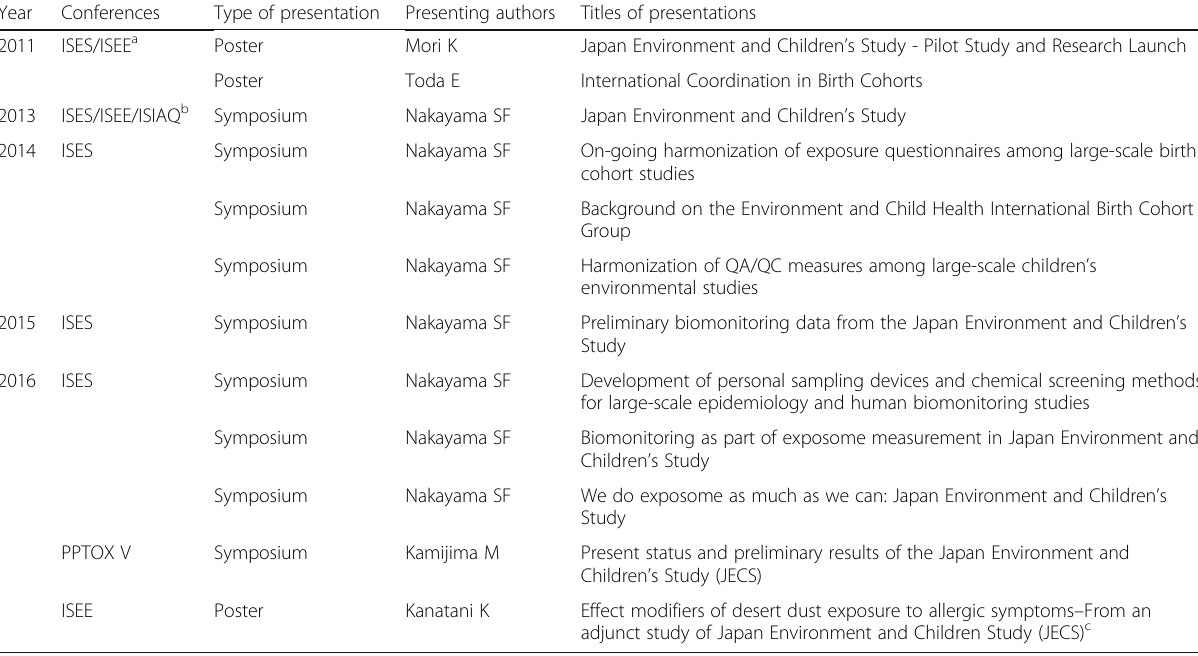
Table 2 Examples of conference presentations relating to activities of JECS International Liaison